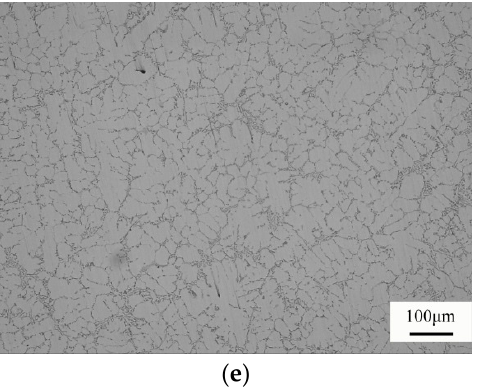
Figure 2. As-cast metallographic diagram of A357 alloy with different Ce content. ( a ) 0%, ( b ) 0.08%, ( c ) 0.16%, ( d ) 0.24%, and ( e ) 0.32%.